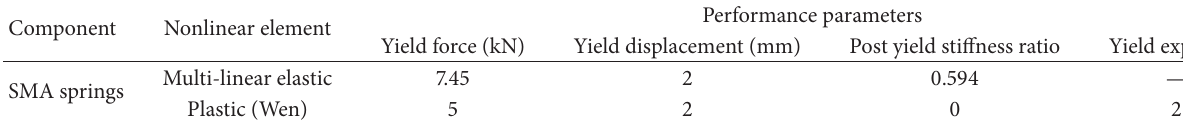
Table 1: Values of parameters for nonlinear element of SMA spring restrainer.